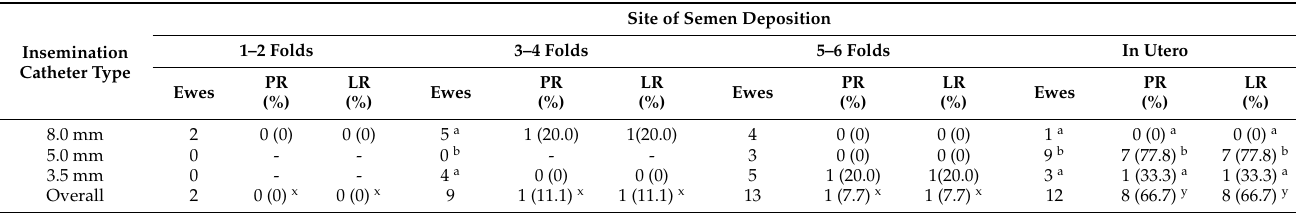
Table 2. Pregnancy (PR) and lambing (LR) rates in relation to the site of semen deposition in the cervical lumen using three different catheters.